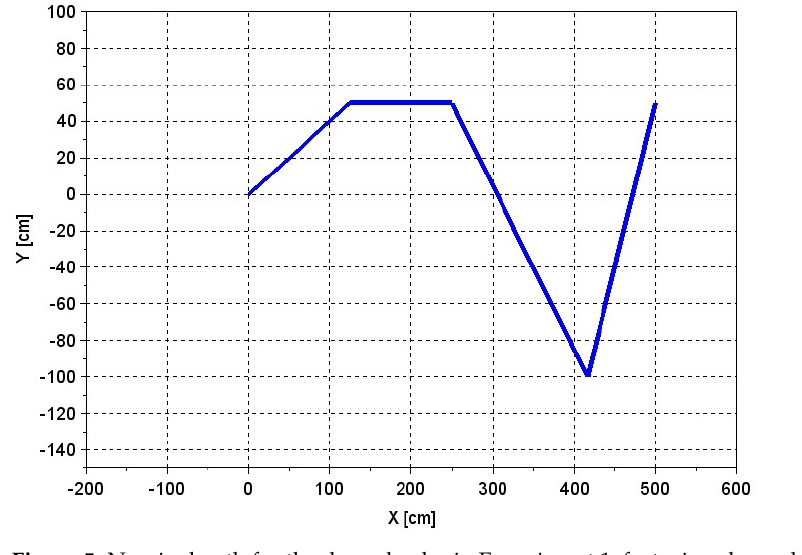
Figure 5. Nominal path for the drone leader in Experiment 1, featuring sharp changes in direction.